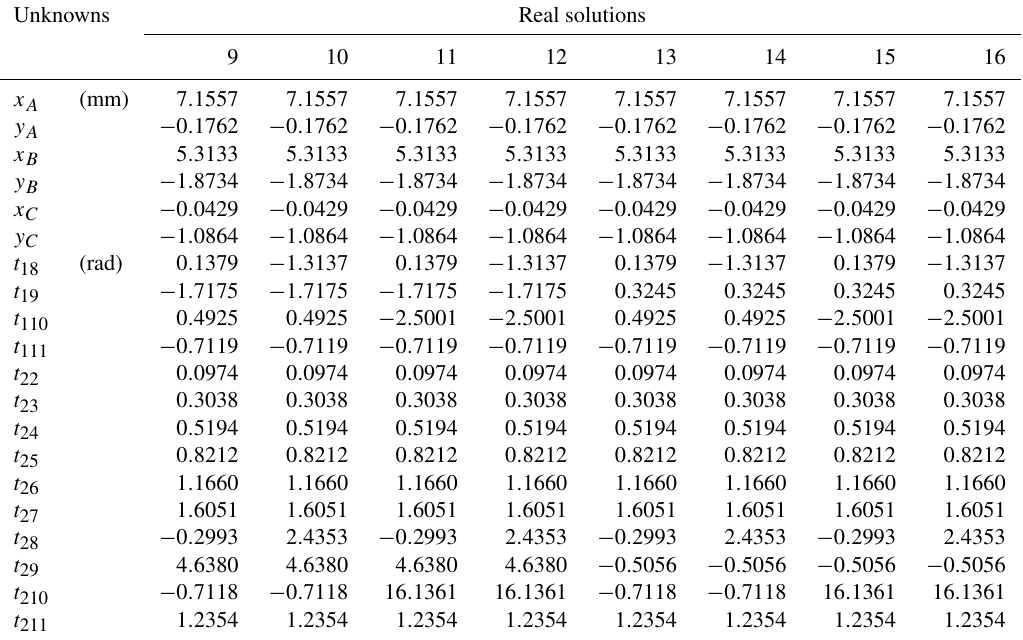
Table A7. Real solutions 9–16.